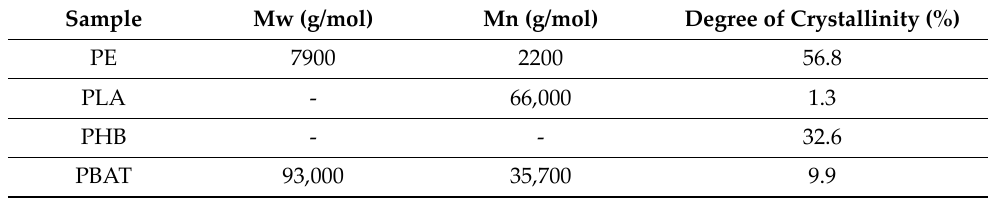
Table 1. Properties of the samples.